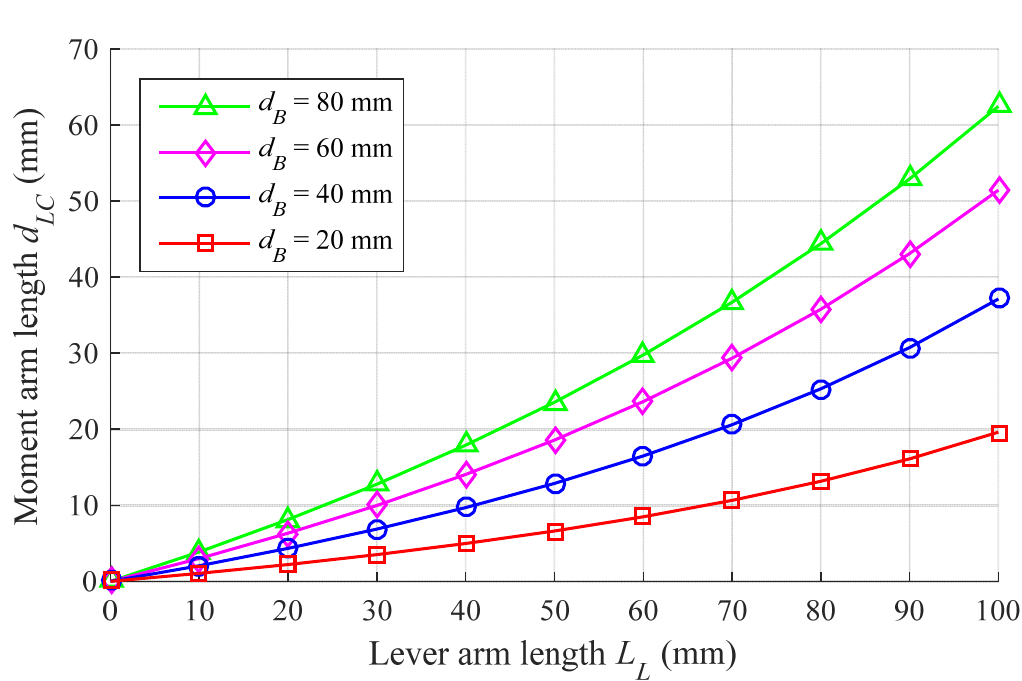
Figure 5. Influence of the lever arm length L L on the moment arm length d LC : L B = 200 mm and d L = 0 with the parallel AB and CD .